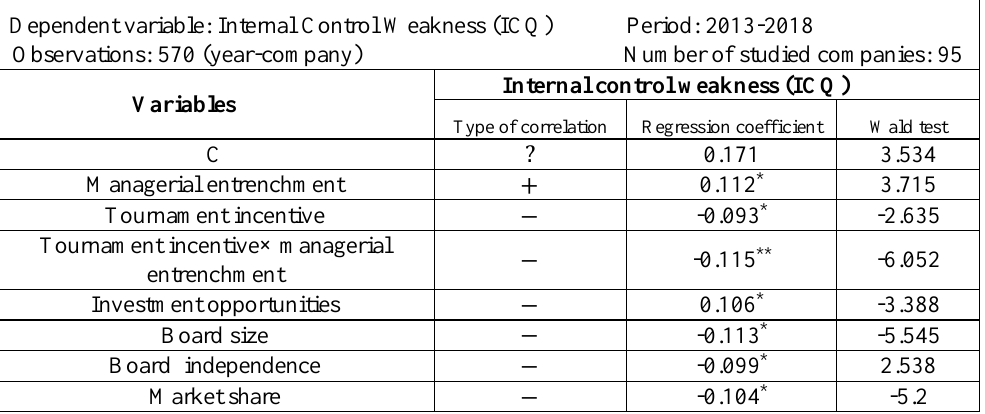
Table 6. The result of testing first hypothesis of the research Dependent variable: Internal Control Weakness